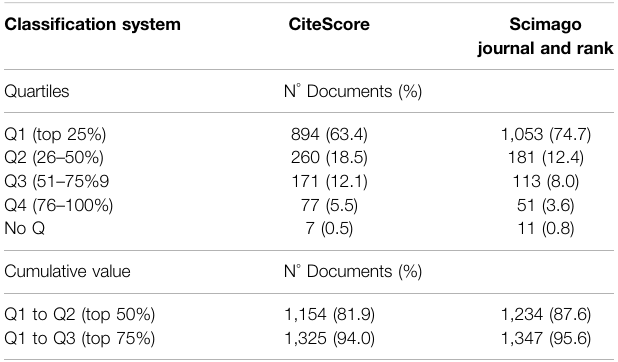
TABLE 6 | Number of documents classi fi ed by journal quartile according to CiteScore and Scimago Journal and